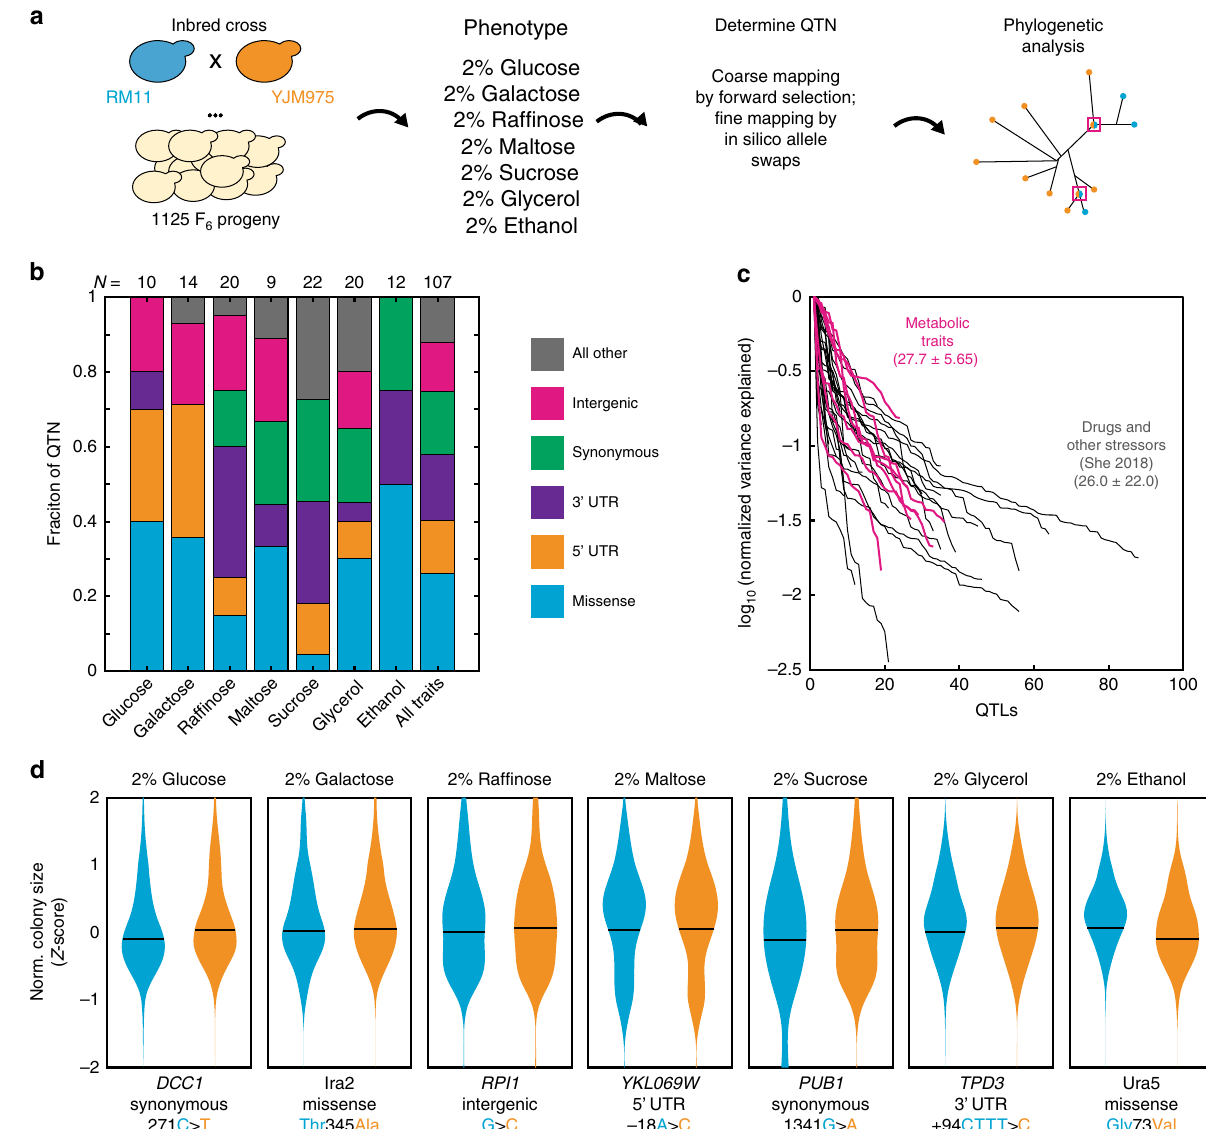
Fig. 1 Mapping complex metabolic traits to single-nucleotide resolution. a Schema of the crossing strategy, phenotyping conditions, genetic mapping, and phylogenetic analysis procedure employed herein. b Fraction of QTN of each functional class for each growth condition tested; “ all other ” includes all other types of polymorphisms, e.g., premature stop codons, frameshifts, loss of a start codon, etc. Indicated at top is the number of QTNs identi fi ed for each trait. c Variance explained per QTL normalized to the maximum variance explained for each growth condition tested (pink); analogous data for growth in the presence of various drug and other stressors are included as a reference for the complexity of drug-resistance traits 8 (gray). Also indicated is the mean ± s. e.m. of number of QTLs identi fi ed per trait for each class. d Effect of selected example QTNs in conditions as indicated. Shown are normalized, Z -scored colony size for each allele. Line indicates the mean. Blue: RM11 allele; orange: YJM975 allele. Source data are provided as a Source Data fi